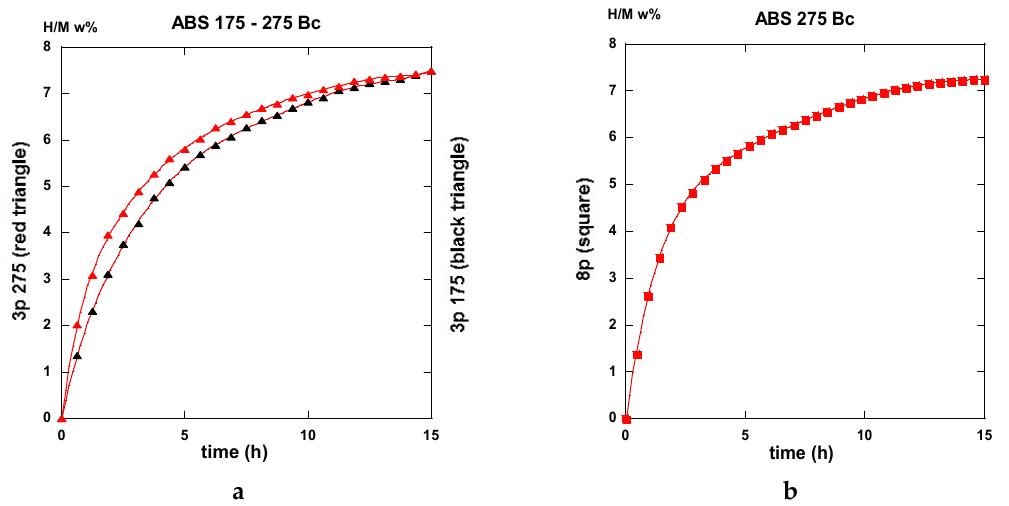
Figure 26. Hydrogen absorption rate (H/M w%) for B C ECAP- treated billets: a —3 passes at 175 °C (black) and 3 passes at 275 °C (red). b —for 8 passes at 275 °C (red). Relative gains (kinetics and uptake) from three to 8 passes is less than for the A mode as shown in Figure 24 because of a more homogeneous micro-structure in the billet.